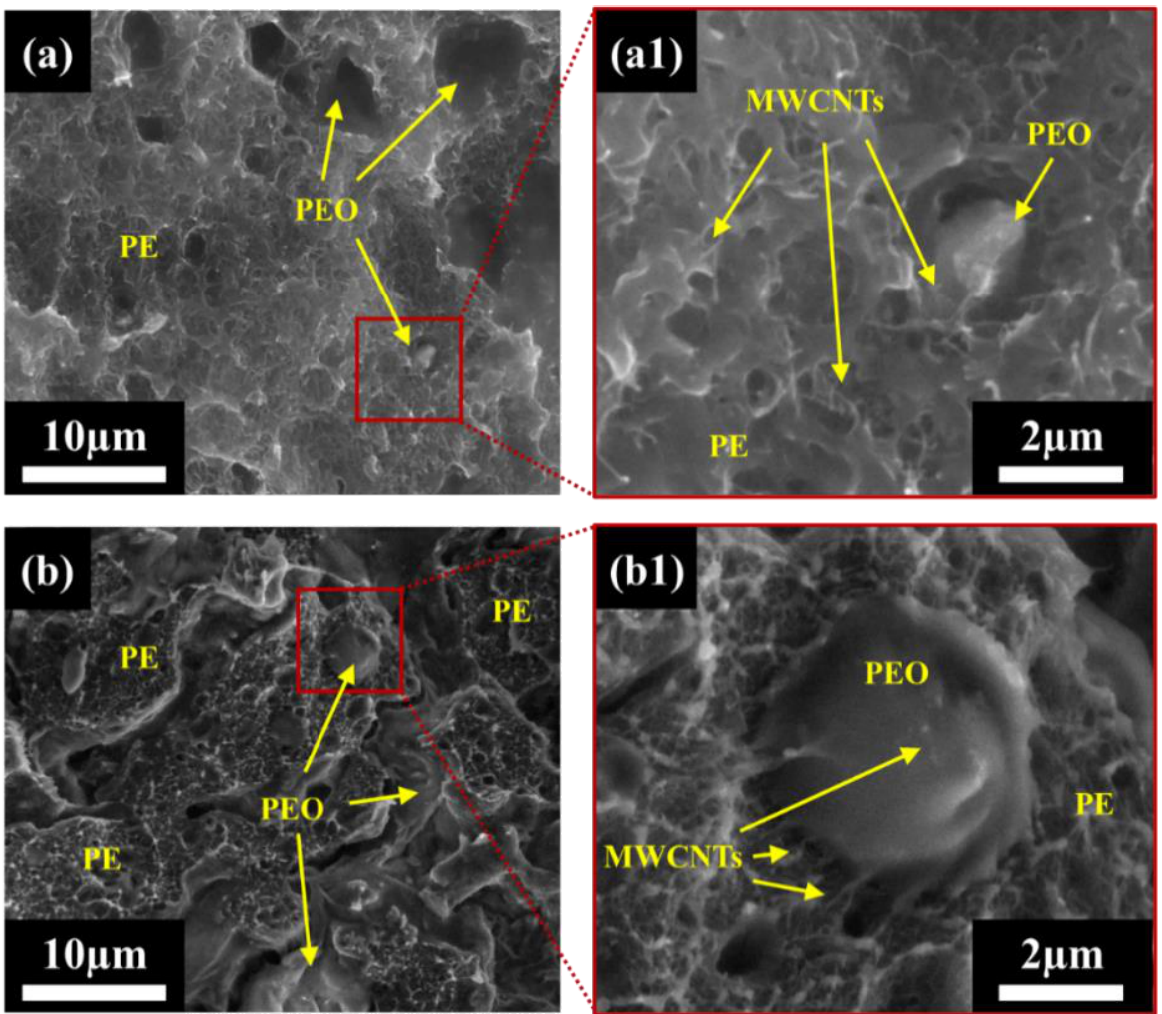
Figure 3. Low field detector (LFD) SEM images of PEO/PE 40:60 with 3 vol% MWCNTs mixed for ( a ) 1 min and ( b ) 10 min. Images ( a1 ) and ( b1 ) show PEO droplets at higher magnification.